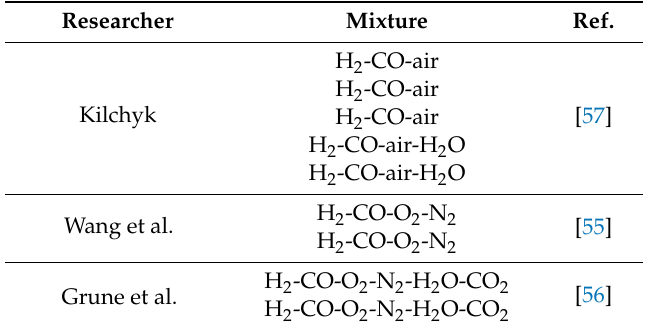
Table 4. Summary of experimental flammability limit studies for binary fuel mixtures. Reproduced from Ref. [54], Korean Nuclear Society: